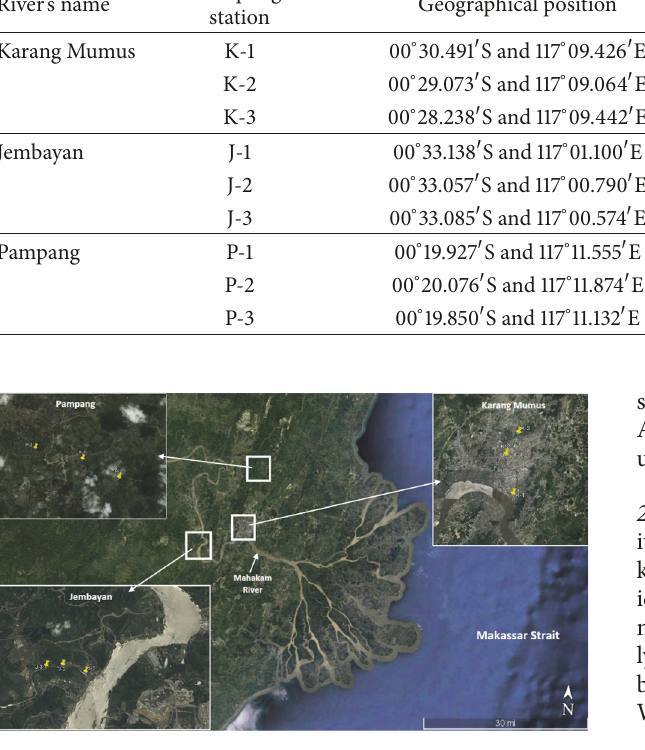
Figure 1: Sampling locations of benthic macroinvertebrate and water quality parameters (source: Google Earth Pro 7.3.1.4507, Build Date February 6,